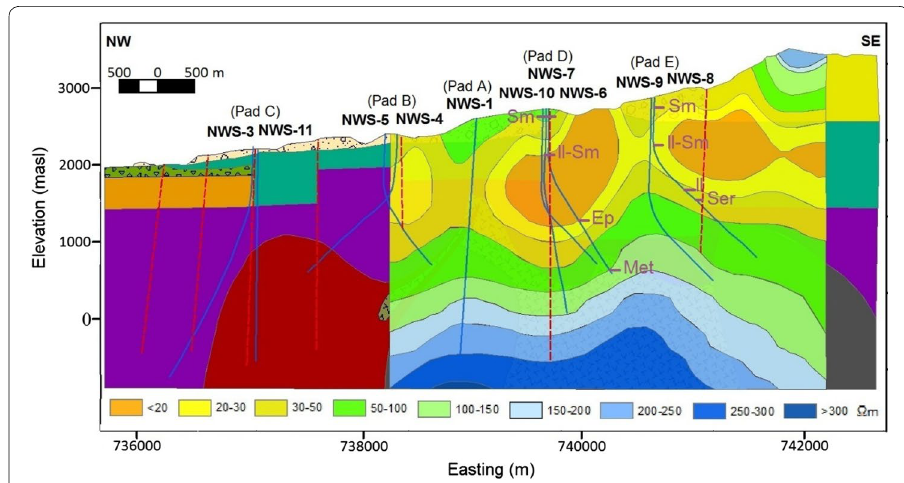
Fig. 5 Resistivity cross section modified from EDC (2010) incorporating wells data and alteration indicators. Sm smectite, Il ilite, Ser sericite, Ep epidote, Me